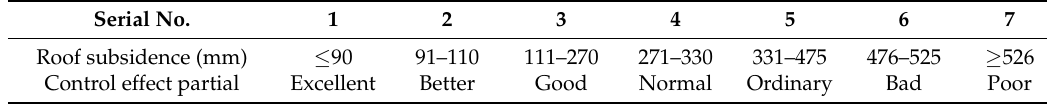
Table 1. Roof control effect partial in working face.